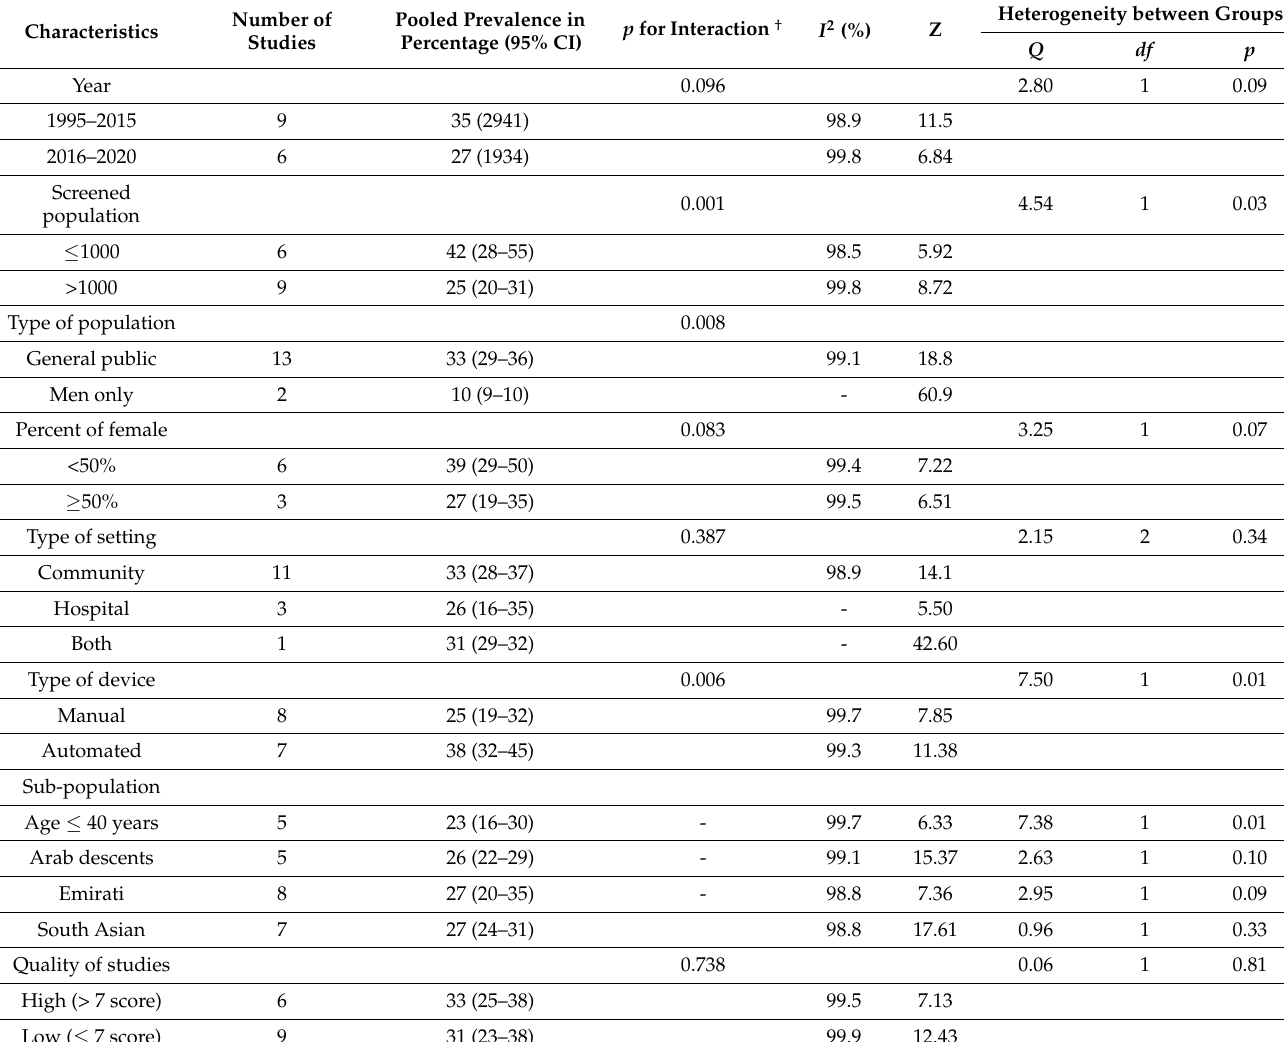
Table 2. Stratified meta-analysis of the prevalence of hypertension in the United Arab